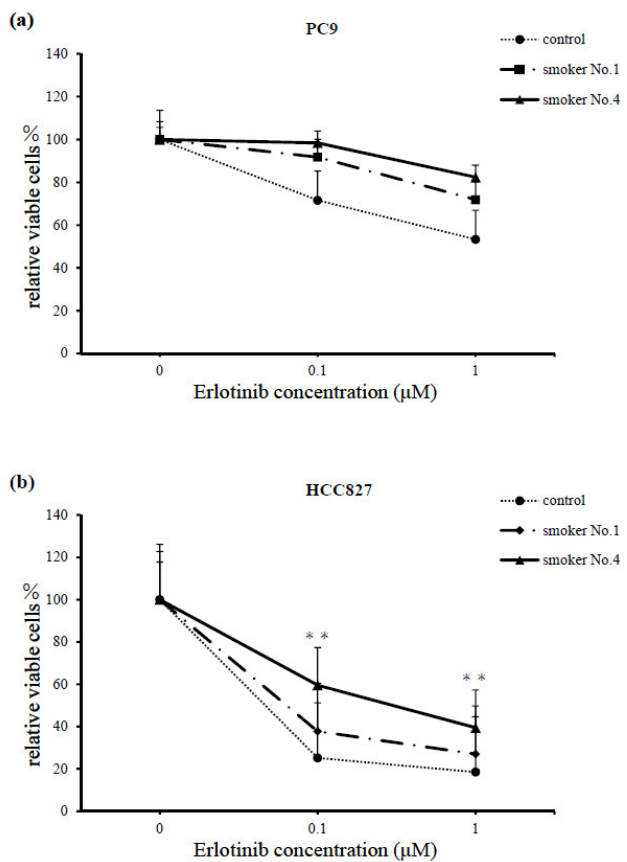
Figure 3. Comparison between smokers No. 1 and 4 with the lowest and highest serum cotinine levels (33.0 and 488.4 ng/mL), respectively. Serum with the highest levels showed stronger resistance to erlotinib therapy over 72 h. ( a ) PC9 cells treated with 0.1 and 1 μM erlotinib, p = 0.8077 and 0.4242, respectively. ( b ) HCC827 cells treated with 0.1 and 1 μM erlotinib, ** p < 0.001. Cell survival was